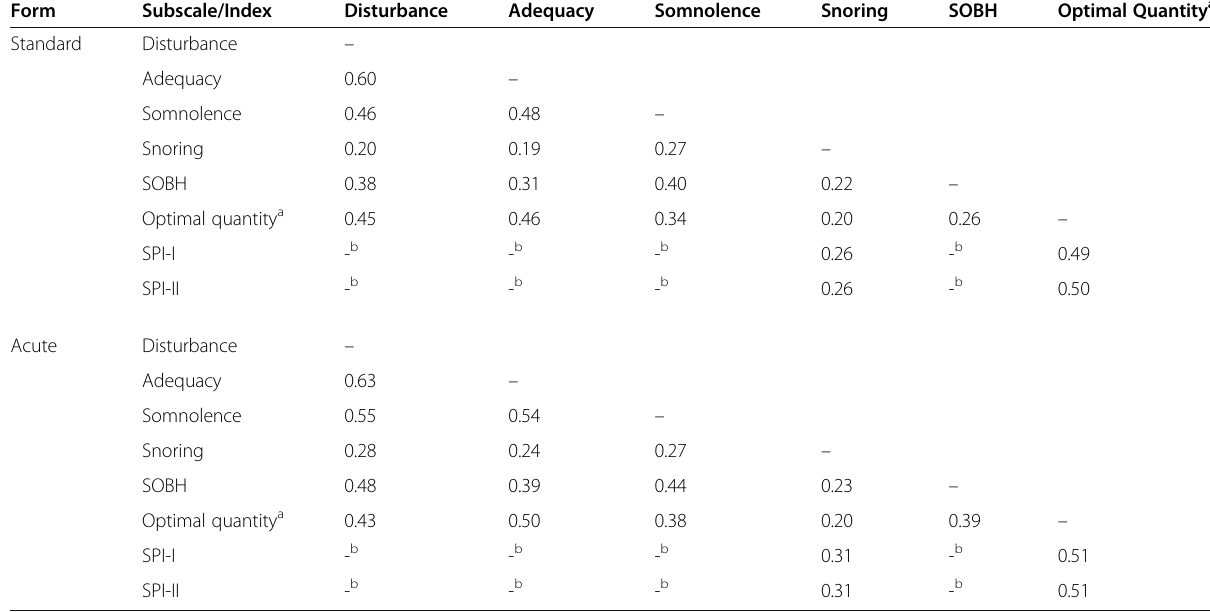
Table 5 Inter-subscale and index-subscale correlations for MOS Sleep-R standard and acute